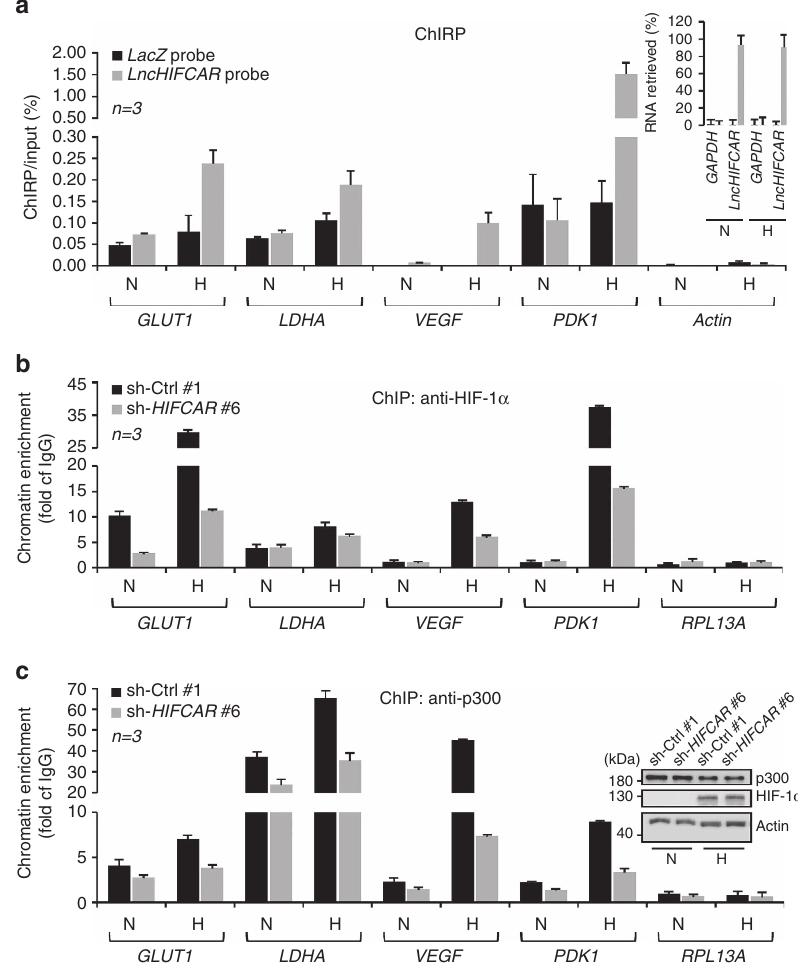
Figure 5 | LncHIFCAR physically binds to the target chromatin and enhances the recruitment of HIF-1 a and p300. ( a ) ChIRP-qPCR detection of LncHIFCAR occupancy on the indicated target loci under normoxic and hypoxic conditions. ChIRP assays were performed with hypoxia (H)- or normoxia (N)-treated SAS cell lysate. Specific tiling biotinylated oligonucleotides complementary to LncHIFCAR or control LacZ RNA were used to pull down the RNA-associated chromatin. The inset graph shows the retrieved RNA level in the streptavidin pulled down complex, quantified by qRT–PCR. GAPDH mRNA was used to evaluate nonspecific binding of the biotinylated probes. The LncHIFCAR -associated HIF-1 target promoters were detected by qPCR. The retrieval of DNA was estimated as percentage of input chromatin, whereas Actin promoter served as a negative control region. ( b , c ) ChIP analysis of HIF-1 a ( b ) and p300 ( c ) association with the promoter regions of HIF-1 target genes. The chromatin was prepared from vector control or LncHIFCAR knockdown SAS cell lines treated with normoxia (N) or hypoxia (H). ChIP was performed with anti-HIF-1 a , anti-p300 or IgG and the recovered DNA was analysed by qPCR. The fold enrichment, indicated by fold of IgG, was calculated by normalizing the levels against nonspecific IgG-bound DNA. Inset, protein levels of HIF-1 a and p300 in control and LncHIFCAR knockdown cells under normoxia (N) and hypoxia (H). Graphs show mean ± s.d. n , the number of independent experiments